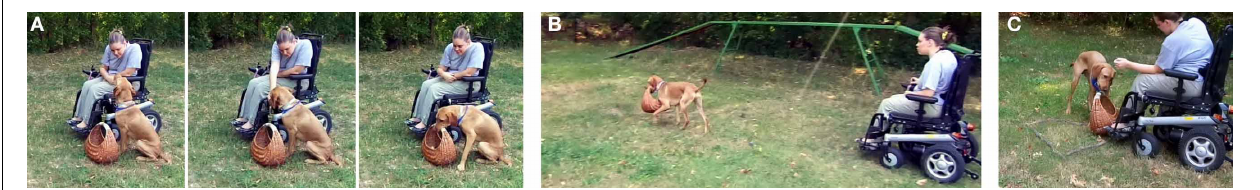
FIGURE 1 | Snapshots from the video on the 3 phases of the test: (A) picking up, (B) carrying, and (C) placing the basket.